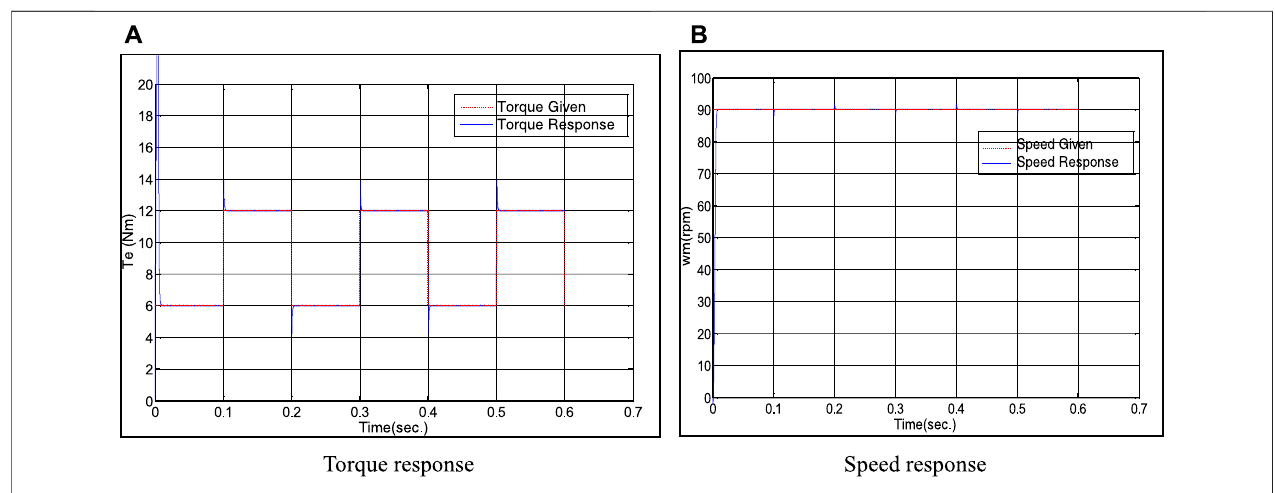
FIGURE 11 | Response curve of RBFNN inverse system decoupling control when torque changes periodically.